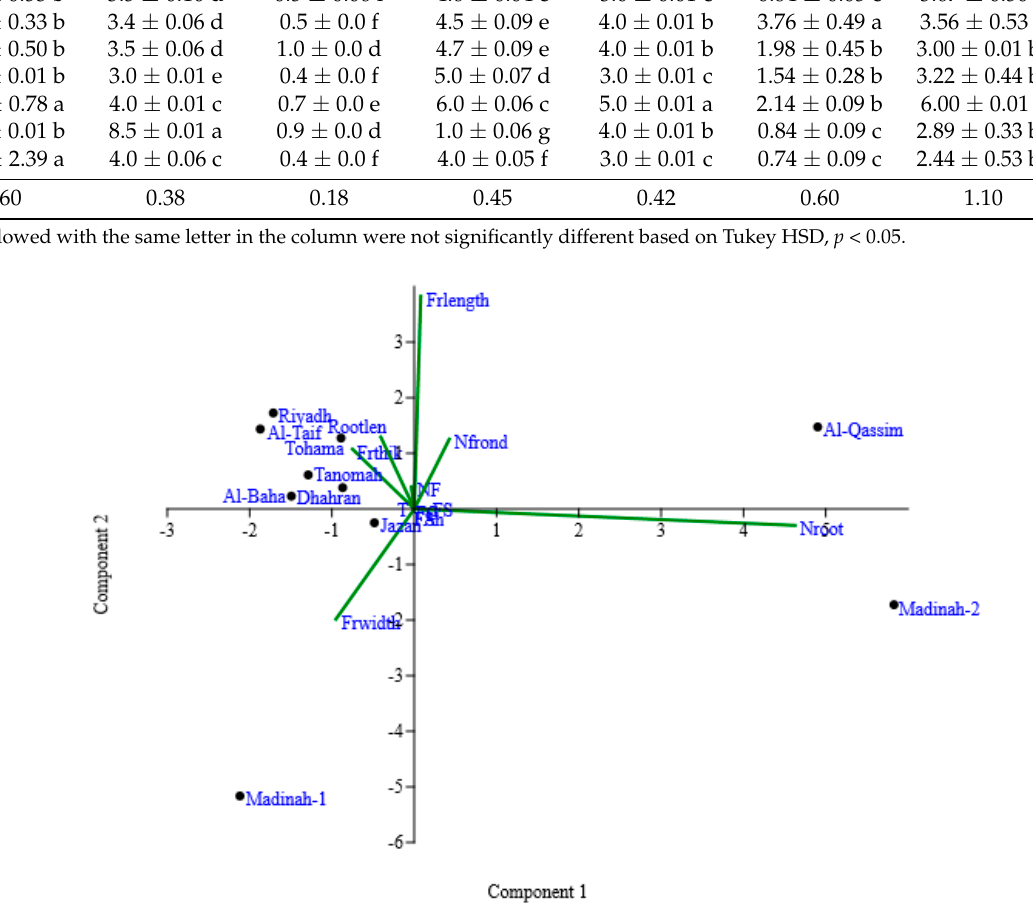
Figure 2. Two-dimensional biplot ordination of the duckweed clones on principal component axes according to qualitative and rescaled quantitative data traits. Principal component 1 (PC1) represented 46.4% of the total variance, and PC2 represented 24.3% of the total variance. Frond shape (FSh); frond symmetry (FS); frond color (FC); frond apex (FA); turions (T); the number of roots—Nroot; frond width—Frwidth; frond thickness (Frthick); frond length (Frlength); the number of contiguous fronds (NCF); root length (Rootlen); the number of fronds (Nfrond).